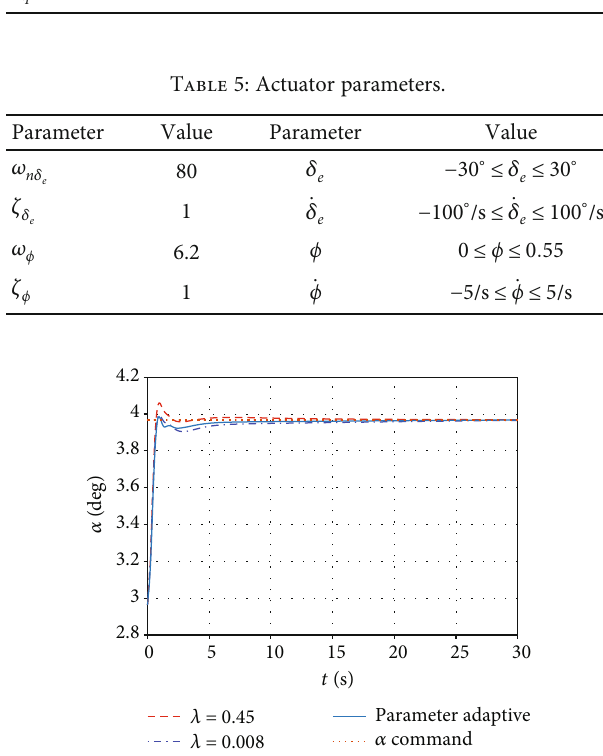
Figure 2: Response curves of di ff erent methods and